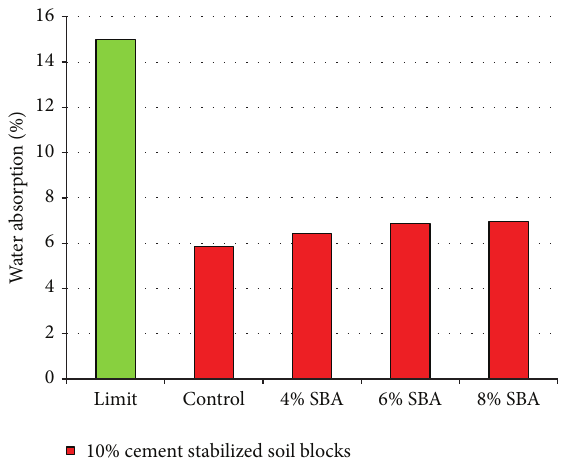
Figure 8: Water absorption levels of 10% cement stabilized blocks admixed with SBA.